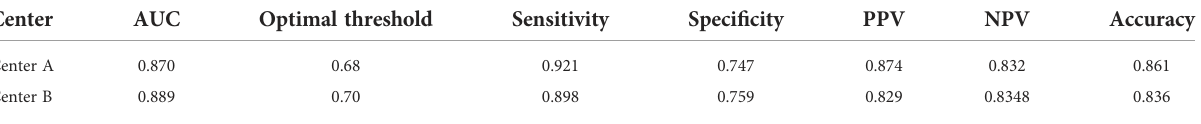
TABLE 3 The AUC, the optimal UGSR threshold, and diagnostic ef fi ciency in both medical centers. Center